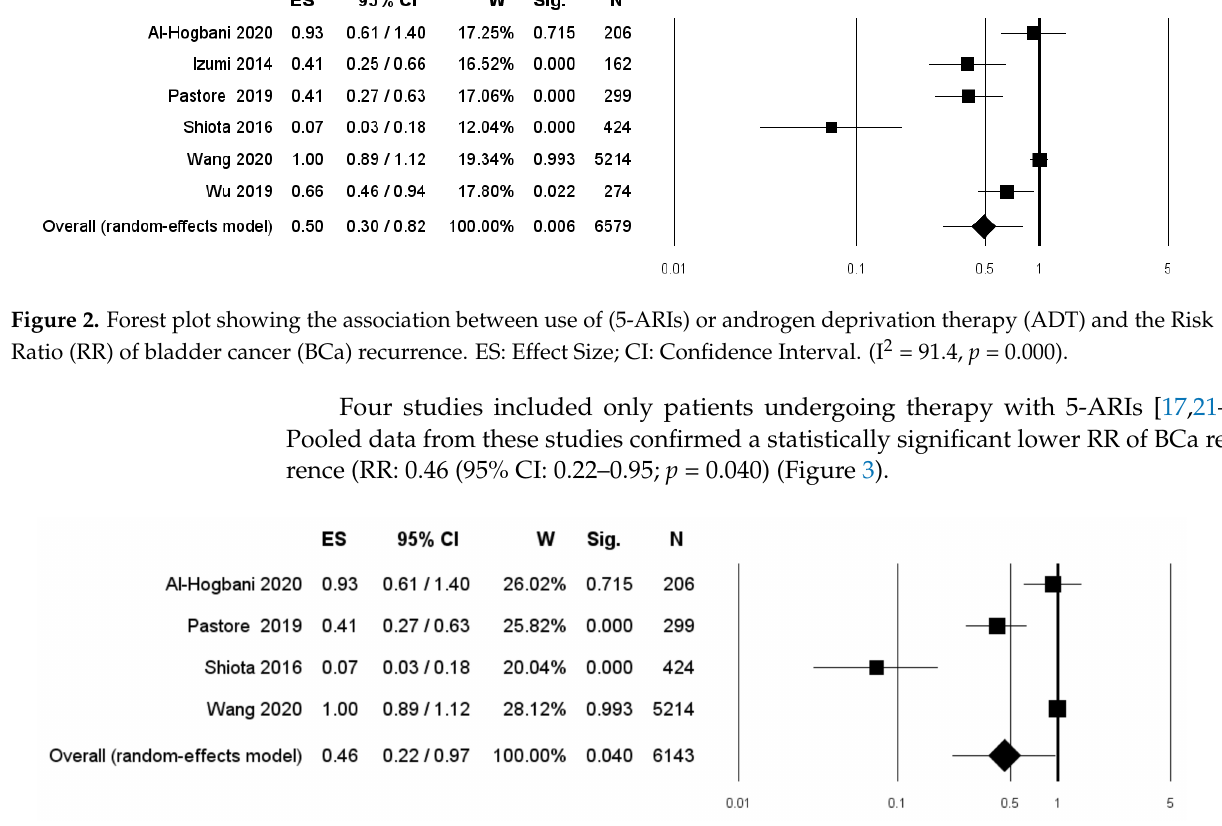
Figure 3. Forest plot showing the association between use of 5-ARIs and the RR of BCa recurrence. ES: Effect Size; CI: Confidence Interval. (I 2 = 93.4, p =0.000).